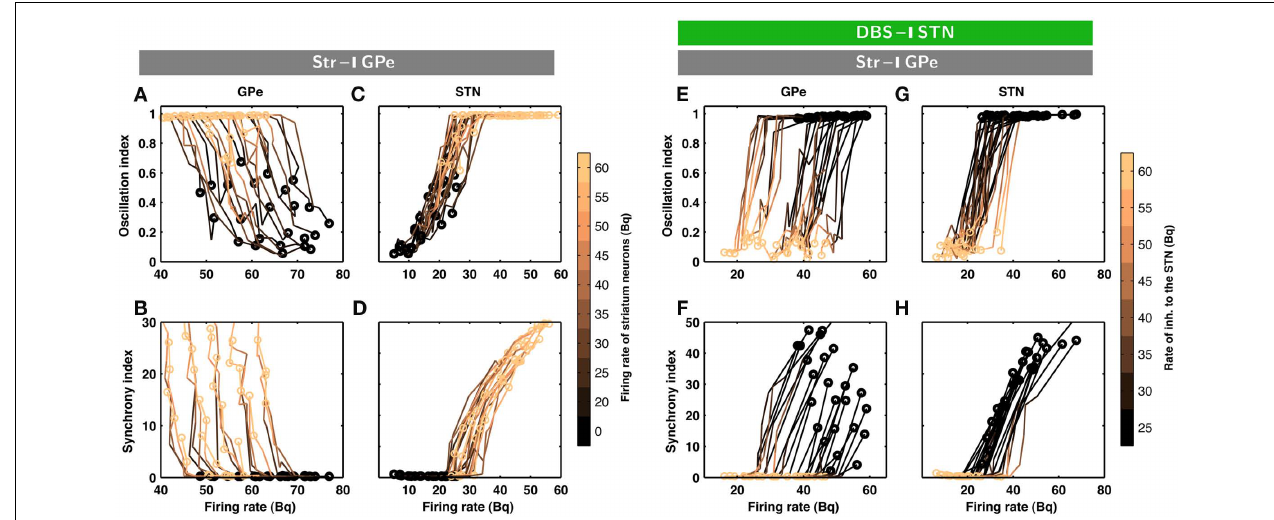
GPe and increased in the STN. (E–H) Evolution of inhibition-induced quenching of oscillations. Every trace corresponds to a different set of network parameters (cf. Table 2 ); a change from dark to bright colors represents an increase in the rate of Poisson type inhibition to the STN neurons. (E) Oscillation index and firing rate in the GPe network for different levels of inhibitory input to the STN.The yellow circles refer to the state of STN-GPe network in absence of striatal inhibition.The dark circles refer to the state of STN-GPe network with strong striatal inhibition. (F) Synchrony index and firing rate in the GPe network for different levels of inhibitory input to the STN. (G) Same as in (E) for STN network. (H) Same as in (F) for STN network. Observe that firing rate, synchrony and oscillations decreased with increasing inhibitory input in both sub-networks of the STN-GPe